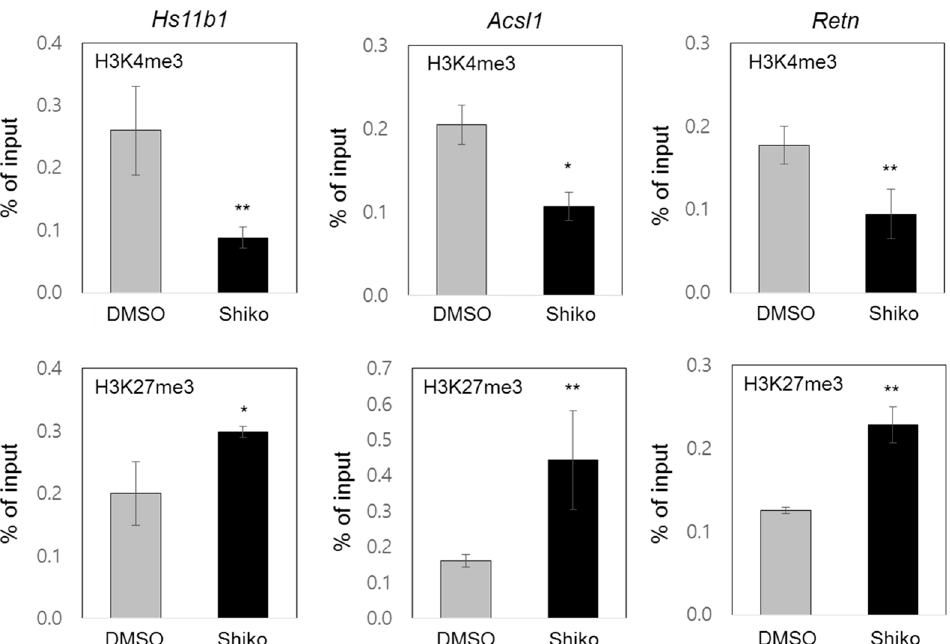
Figure 4. Epigenetic regulation of PPAR γ target genes by shikonin. Eight days after adipogenesis, 3T3-L1 cells were fixed and harvested for ChIP assays using the indicated antibodies against H3H4me3 and H3K27me3. Promoter occupancy was determined using qPCR and primer sets on the targeted promoters of three genes ( Hs11b1 , Acsl1 , and Retn ). Data are represented as means ± SDs for three independent experiments (* p < 0.05 and ** p < 0.01).